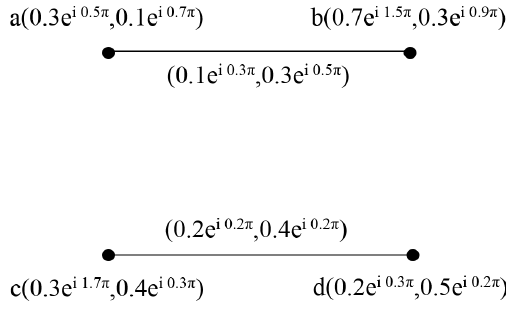
Figure 5. Complex intuitionistic fuzzy graphs of G 1 and G 2 .